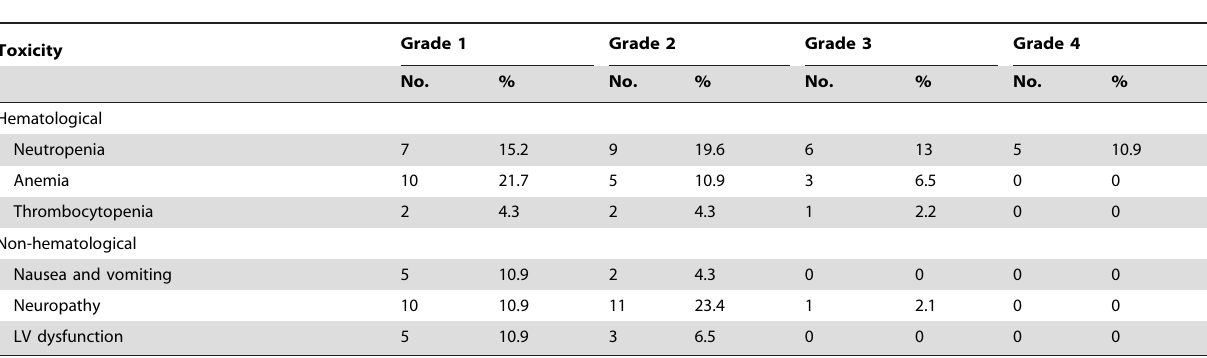
Table 5. Hematological and non-hematological